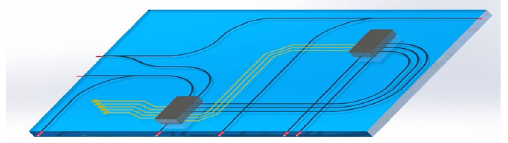
Fig. 1: Schematic drawing of a thin glass layer containing optical waveguides (black) and electrical wiring (yellow) on the top sur- face.